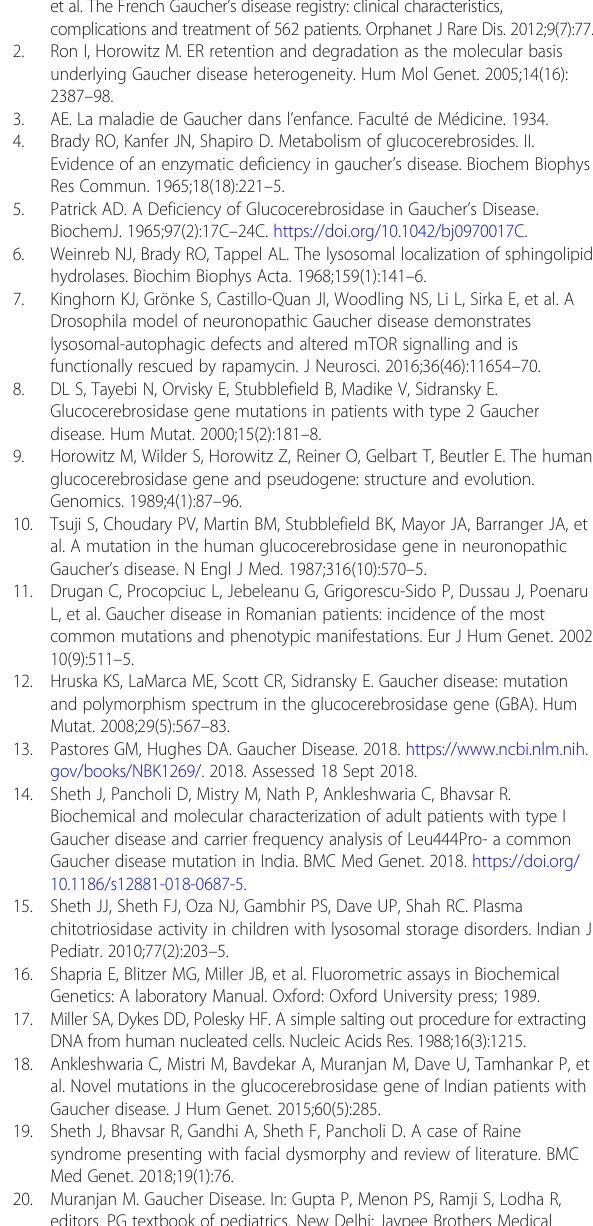
Abbreviations 4-MU: 4-Methylumbelliferyl- β -D-N,N ′ ,N ″ -triacetylchitotrioside; dbSNP: